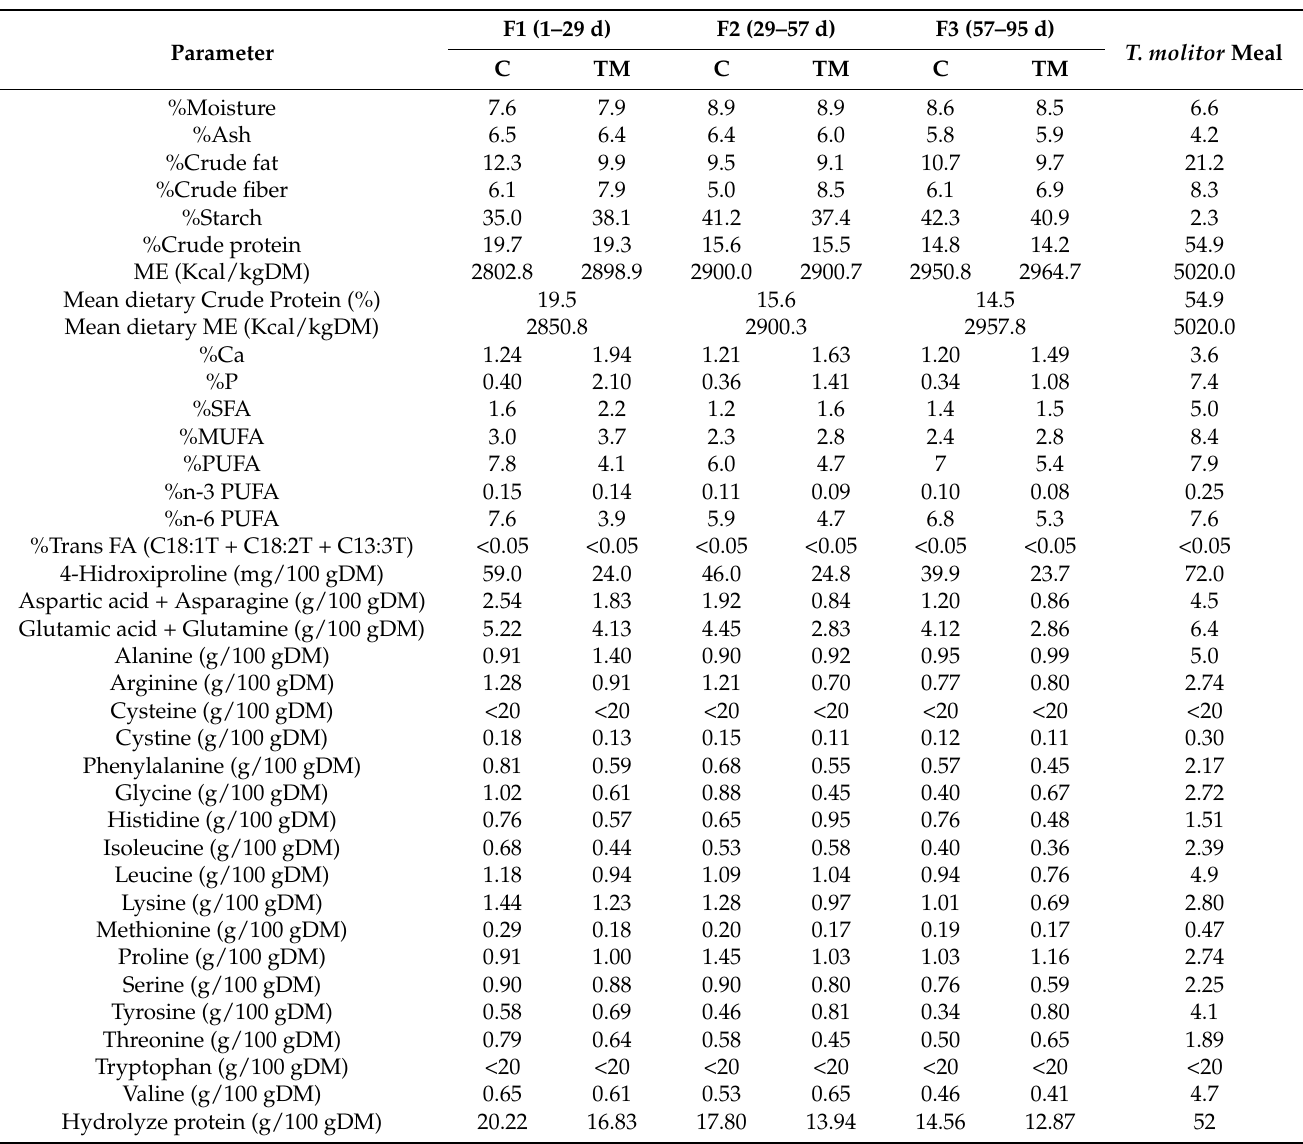
Table 2. Chemical/nutritional characteristics of the experimental diets for the two studied groups of